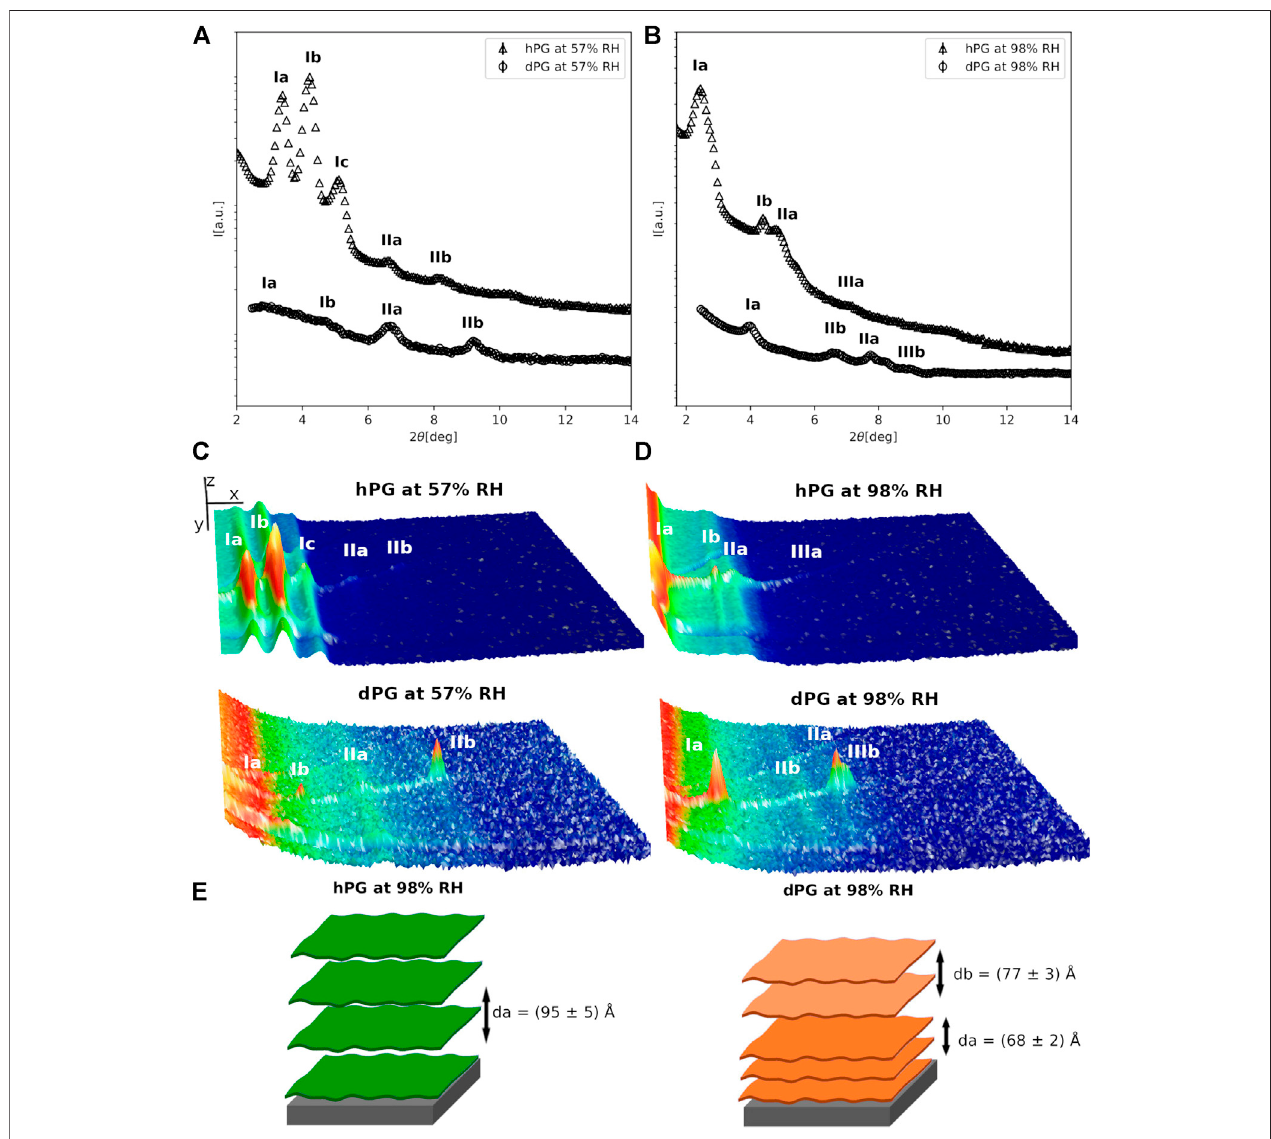
FIGURE 3 | (A,B) Neutron diffraction data collected for hPG and dPG multilayers at 57%RH (A) and 98%RH (B) prepared by deposition of an aqueous vesicle suspension. (C,D) 3D representation of the detector images corresponding to the diffraction pro fi les reported in (A) . In (C,D) the sample angle ( ω ) and the angle at the detector (2 θ ) are reported on the x and y direction respectively, while the intensity of the peak is reported on z direction. In (A – D) the different diffraction peaks are identi fi ed with Roman numbers, while the letters a and b are used to distinguish the different lipid phases. The data collected for the hPG multilayer are scaled for visualization. (E) Cartoon representation of the two multilayers with their characteristic d